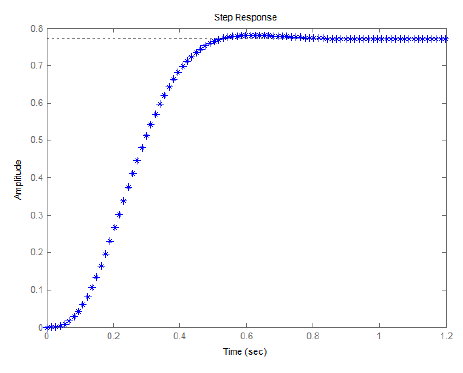
Figure 6. Step Response for the Closed Form